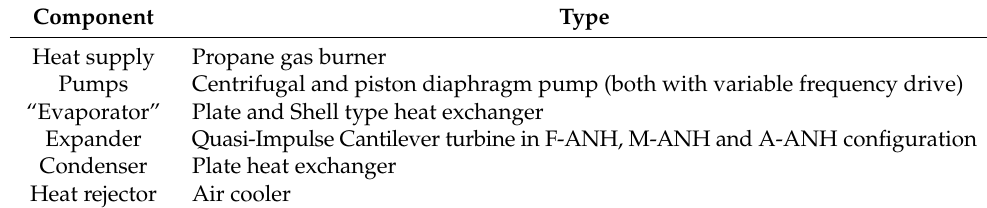
Figure 2. Photograph ( a ) and P&ID scheme ( b ) of the experimental ORC plant at the University of Bayreuth. Table 2. Main components of the ORC test rig.